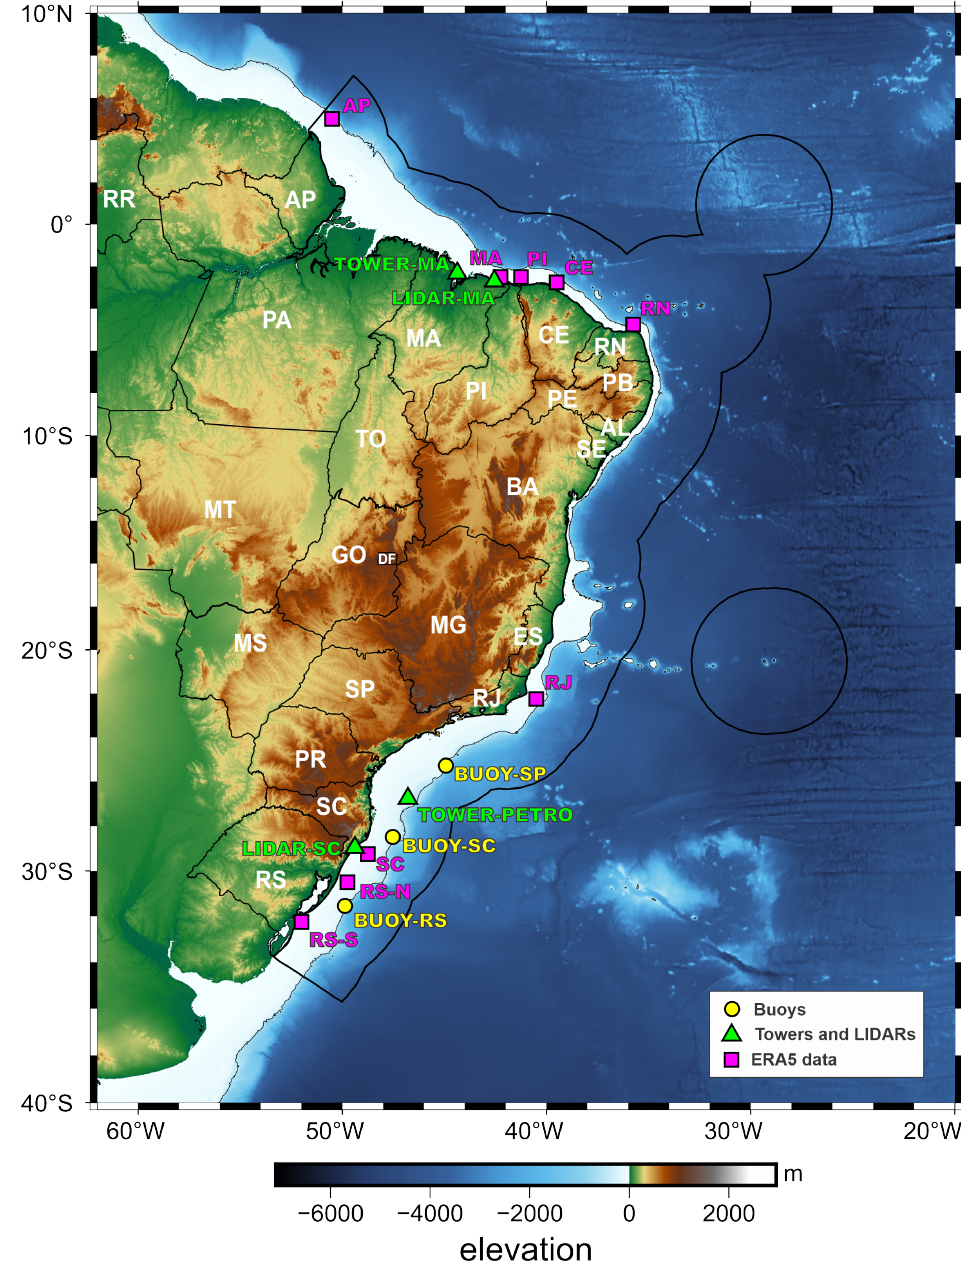
Figure 2. Study region. Magenta squares indicate the ERA5 stations (clusters) extracted for wind farm simulations. Observational points used for ERA5 validation are meteorological buoys (yellow bullets) and towers and LIDARs (green triangles). The colored bar indicates elevation in meters. The thin line represents the 500 m isobath. Coastal states with stations selected for analysis are: Amapá (AP), Maranhão (MA), Piauí (PI), Ceará (CE), Rio Grande do Norte (RN), Rio de Janeiro (RJ), Santa Catarina (SC), and Rio Grande do Sul (RS). The Exclusive Economic Zone is delimited by a thick black line. Map produced with PyGMT [52]